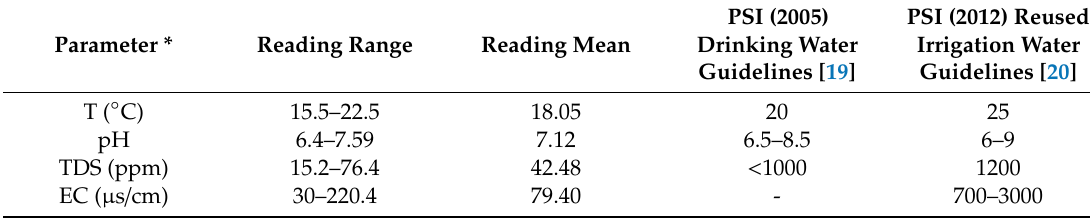
Table 2. Physical and chemical analysis for the condensate water